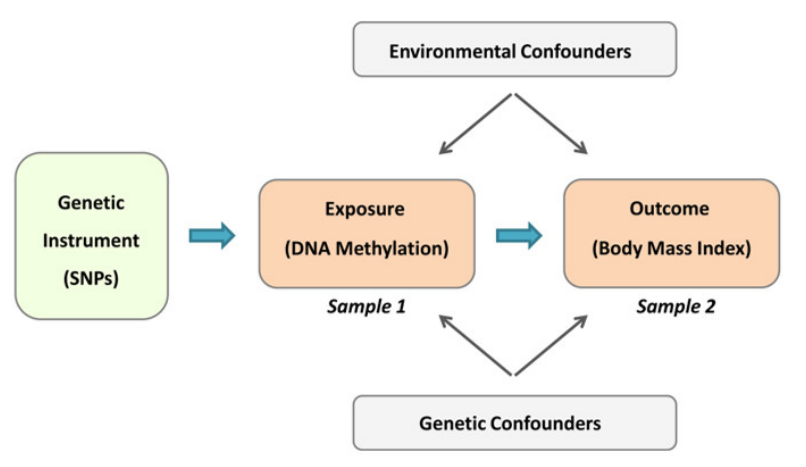
Figure 1. Concept of two-sample Mendelian randomization (MR) design. Under this design, we first constructed an instrument based on a set of independent SNPs that were significantly associated with the exposure in the first sample. Next, we contrasted effect sizes (betas) of SNPs on the exposure with their corresponding effect sizes on the outcome (obtained from the second sample) to find out if there was a significant association. This design is immune to confounding environmental factors because it uses SNPs as instrument. Furthermore, by removing SNPs with peliotropic effect, genetic confounding is prevented. Further information is provided in the Methods section.Examining the association between change in DNA methylation at every site in the genome and obesity using MR is cumbersome. Therefore, in this study, we used a SNP-based multiomics pipeline that also included MR, in order to efficiently narrow down our search and identify meth- ylation sites that contribute to the risk of obesity. We validated our findings through the replication stage; we also investigated the mechanism whereby these sites contribute to obesity by integrating eQTLs data into our analysis.